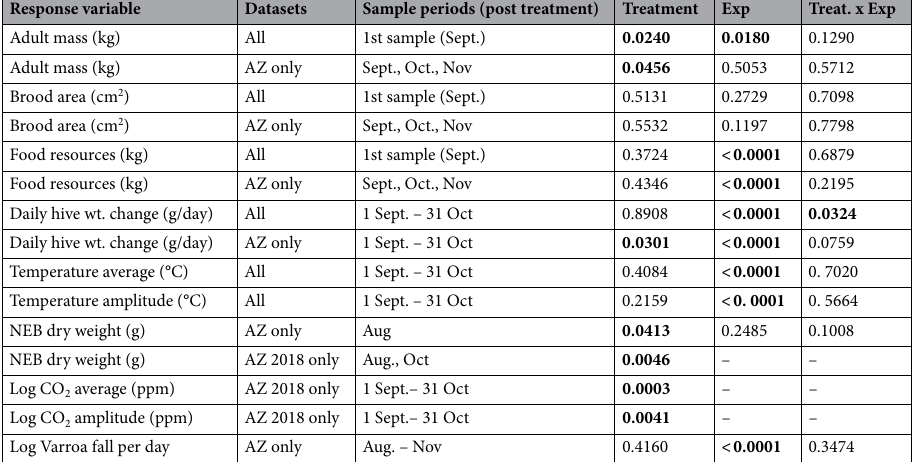
Table 2. Summary of results for MANOVA analyses for treatment and experiment on different response variables. “All” indicates that all three experiments were included in the analysis; “AZ only” indicates that only the Arizona experiments were included. The covariates in all analyses were pre-treatment values of those variables. Newly Emerged Bee (NEB) dry weight data were only collected in Arizona and CO 2 data were only collected in the AZ 2018 study. Numbers in bold indicate signficance at P <